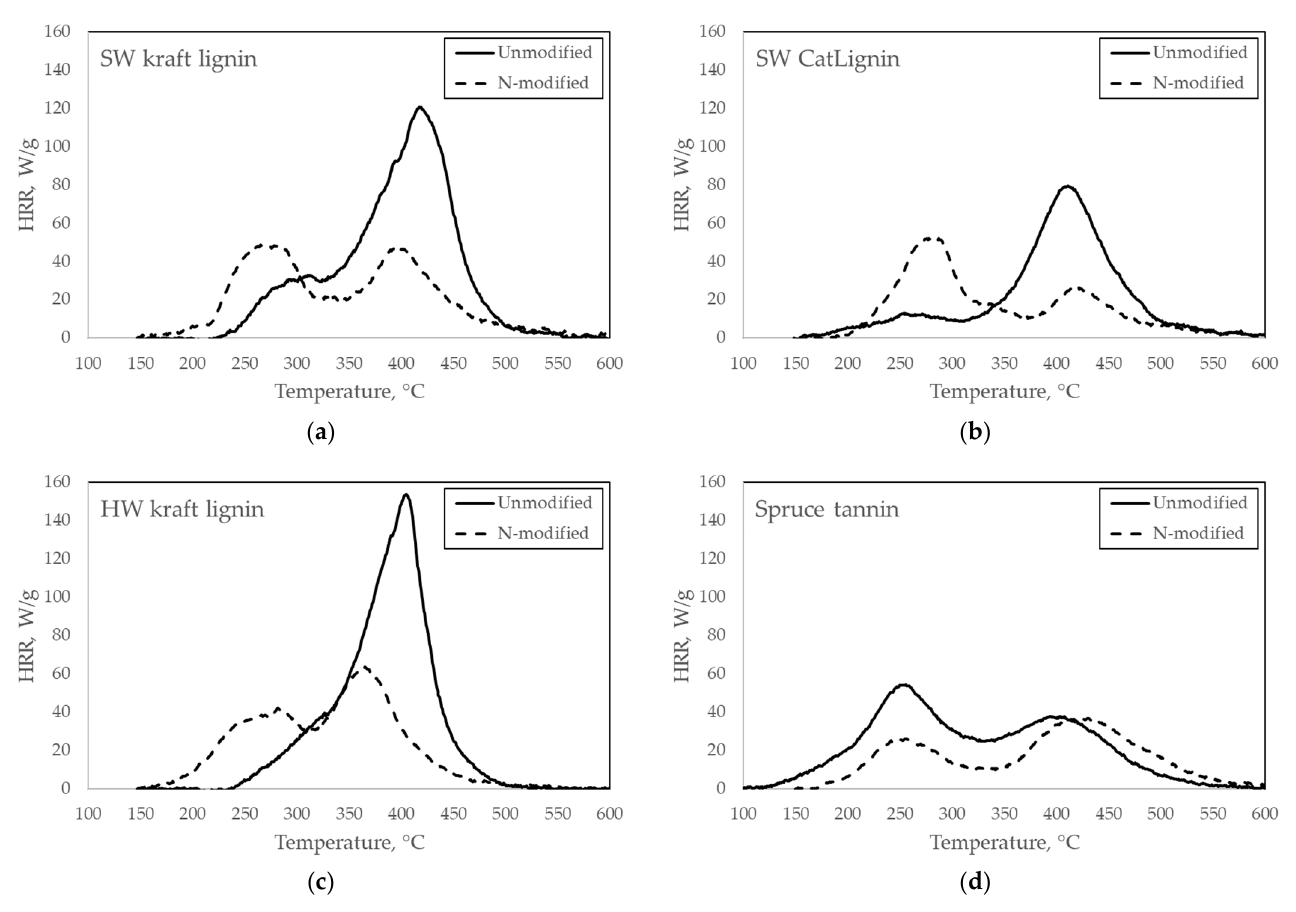
Figure 3. Heat release rate (HRR) in the MCC tests of unmodified and N-modified pure compounds: ( a ) SW kraft lignin, ( b ) SW CatLignin, ( c ) HW kraft lignin, and ( d ) Spruce tannin. The result of test 1 is shown for each compound. Table 3. Lignin content and filtration retention of bleached kraft pulp combined with HW kraft lignin and retention aids. Mixtures with >95% retention were analysed in